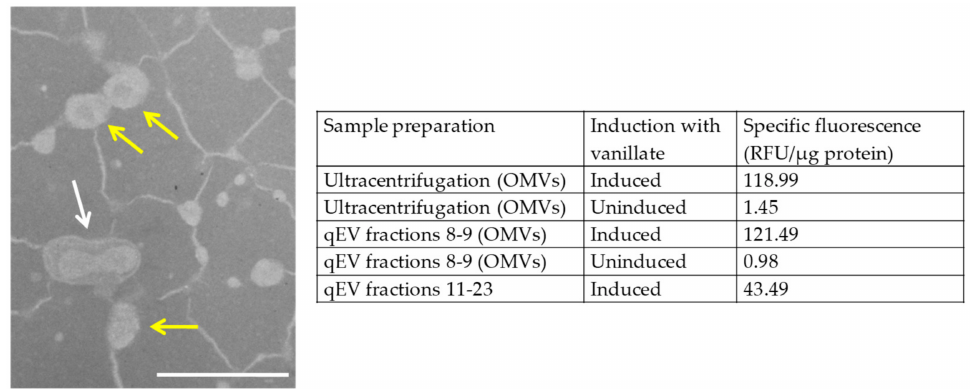
Figure 1. ( Left ): Transmission electron micrograph of OMVs purified from EH715 by size exclusion chromatography (pooled fractions 8 and 9). Example OMVs are shown with a yellow arrow, a potential fusion of two OMVs is indicated with a white arrow. Bar = 200 nm. ( Right ): Mean specific fluorescence values of samples prepared by qEV size exclusion chromatography and ultracentrifuga- tion, induced and uninduced with 200 µ M